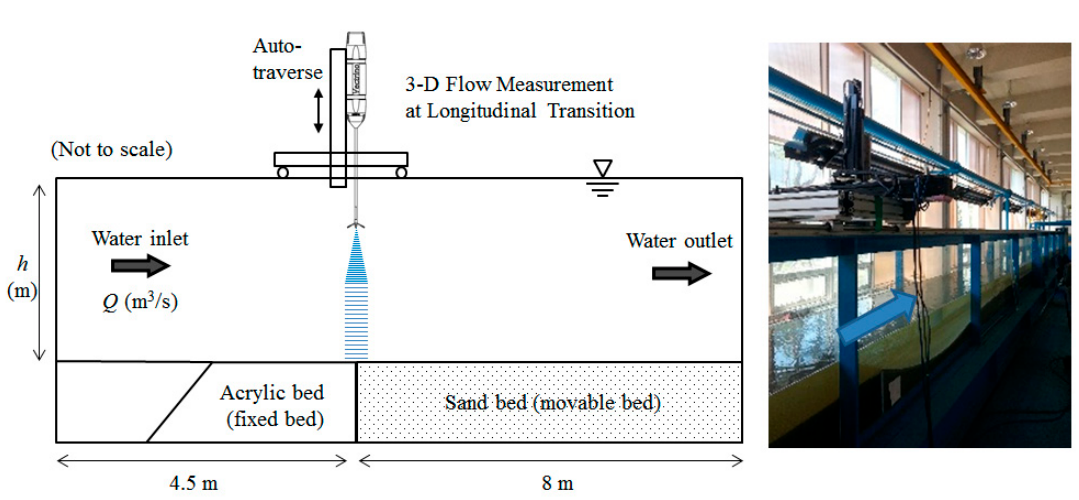
Figure 1. Laboratory experiment setup sketch ( left ) and real picture ( right ) [11].